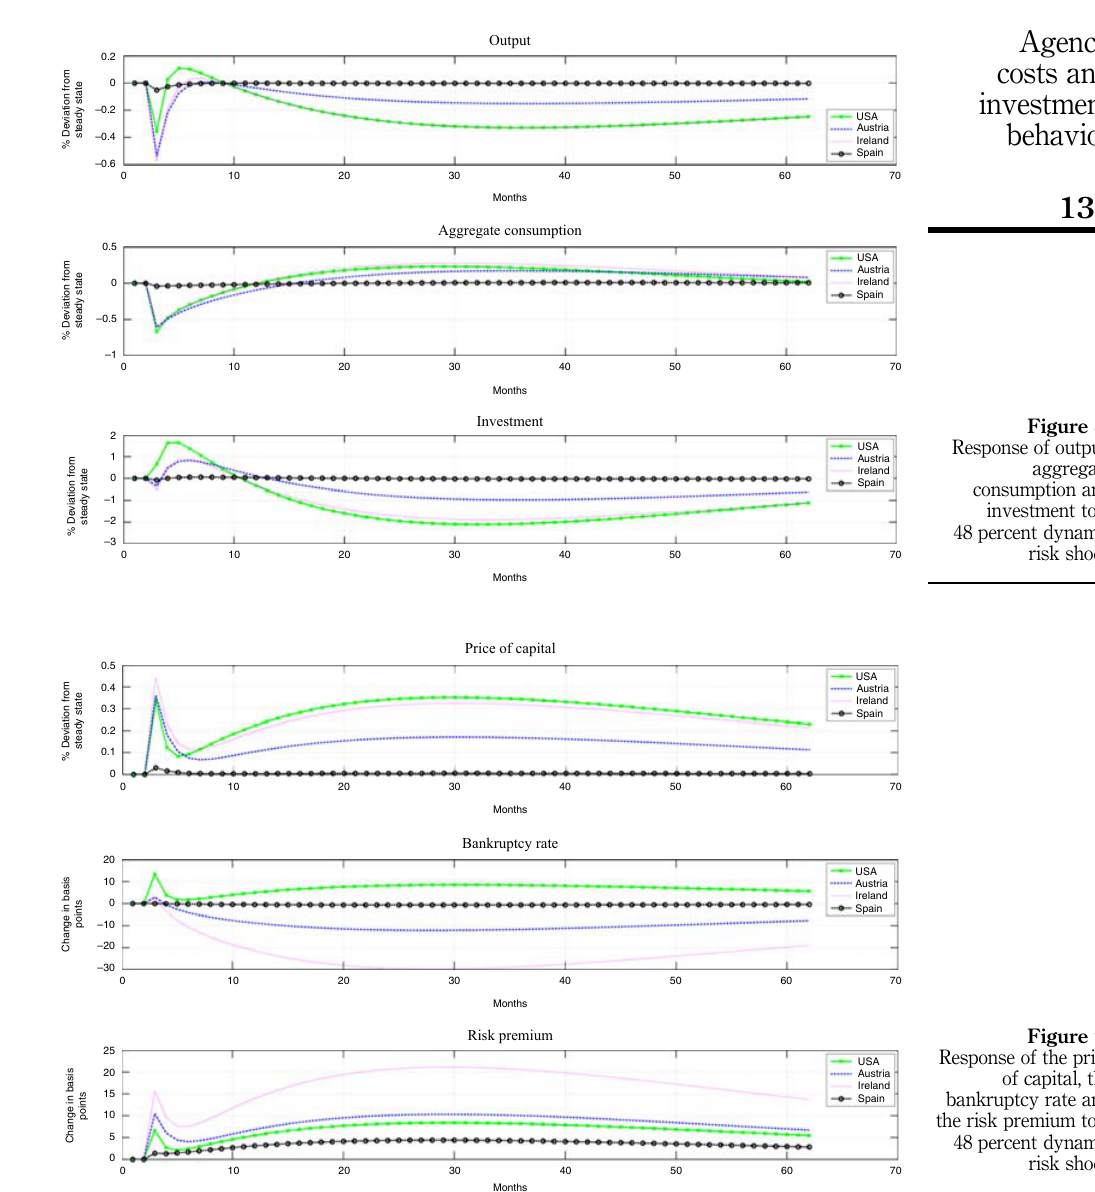
Figure 9. Response of the price of capital, the bankruptcy rate and the risk premium to a 48 percent dynamic